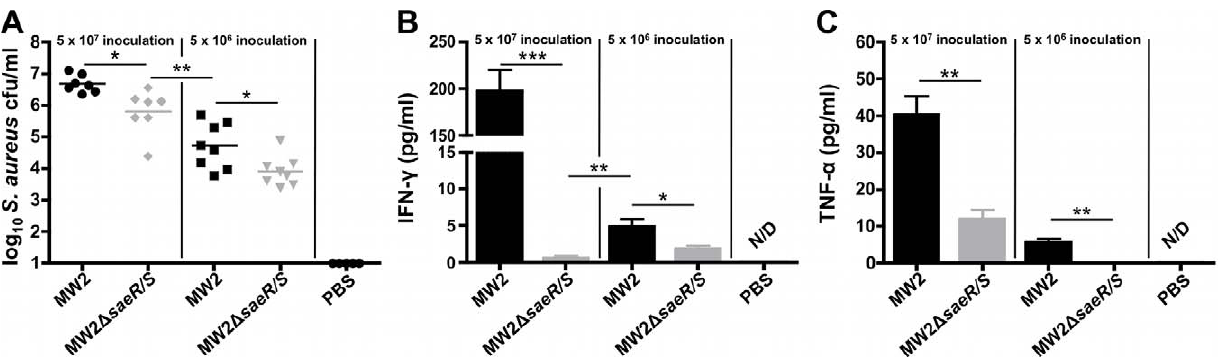
Figure 4. SaeR/S significantly increases IFN- c and TNF- a at the site of infection during invasive disease. Mice were inoculated i.p. with MW2 or MW2 D saeR/S (5 6 10 7 or 5 6 10 6 cfu) for 10 hours. ( A ) Bacterial burden in peritoneal exudates. Concentrations (pg/ml) of ( B ) IFN- c and ( C ) TNF- a in peritoneal exudates. * P , 0.05, ** P , 0.01 and *** P , 0.001 compared to MW2 in each panel as determined by t test. Protein levels for uninfected tissue controls were undetectable. Results are from 7 mice/group for high bacterial infection (5 6 10 7 cfu), 8 mice/group for 10-fold reduced bacterial